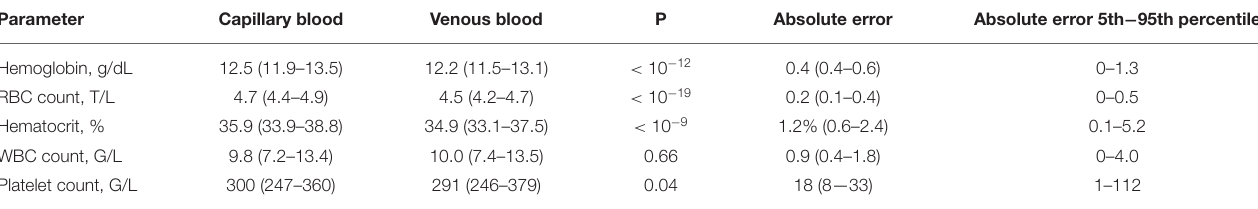
TABLE 2 | Matched-pairs comparisons of hematologic parameters in capillary and venous blood. Parameter